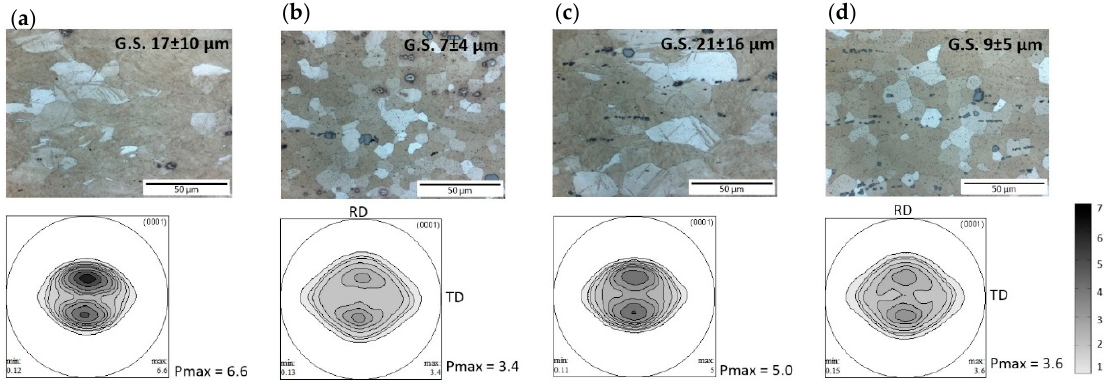
Figure 5. The optical micrographs and the recalculated (0002) pole figures of the sheets rolled by the 500-inc and 500-dec schemes, ( a ), ( c ) as-rolled condition and ( b ), ( d ) after annealing for 600 s at 400 °C, respectively.